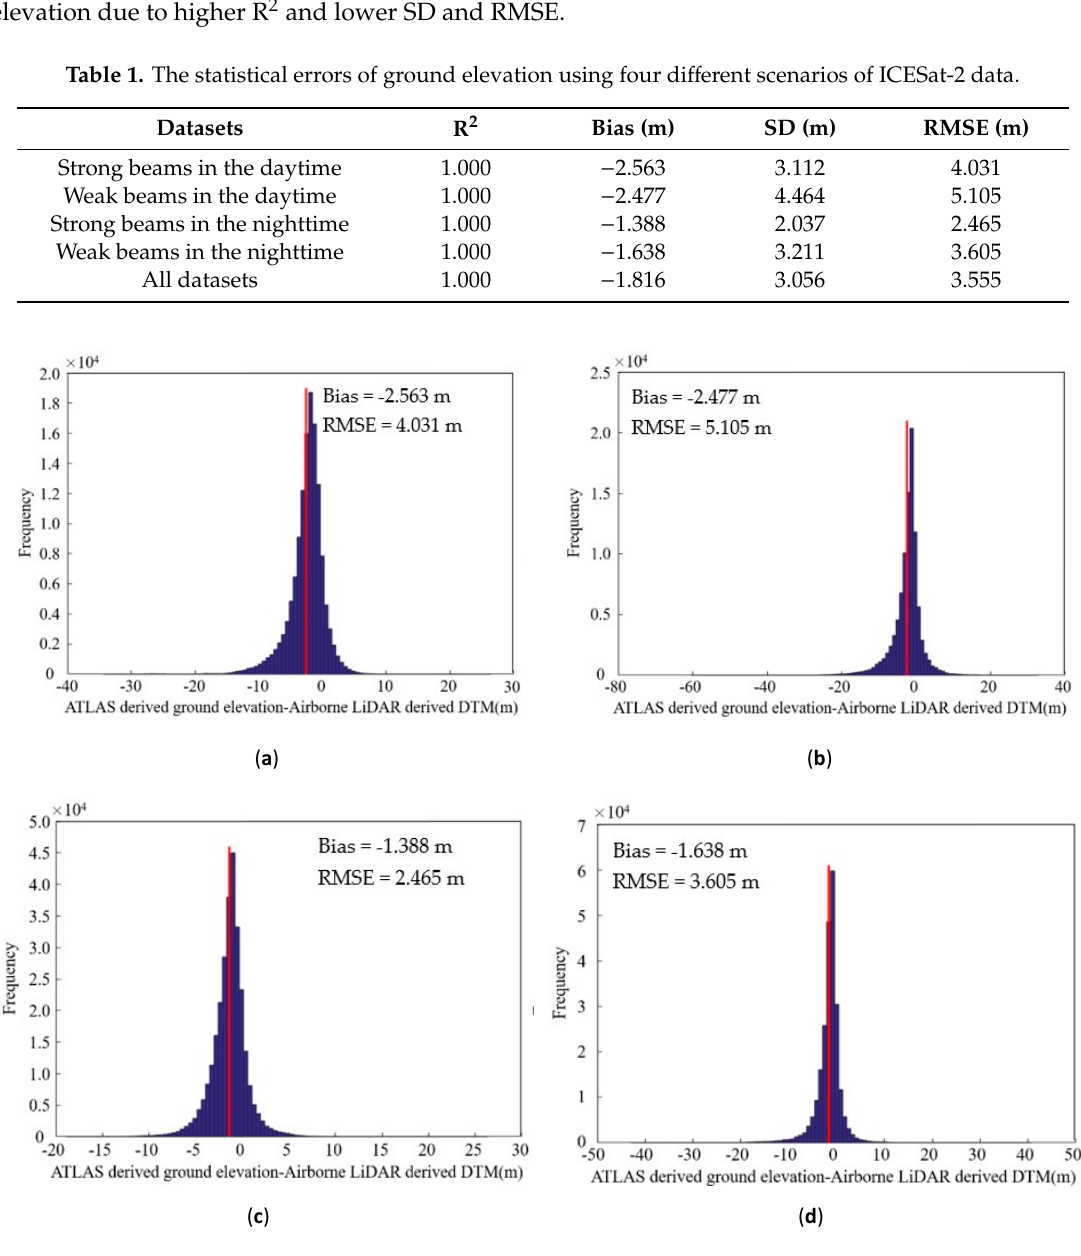
Figure 5. The frequency histogram of ground elevation errors using four different scenarios of ICESat-2 data ( a ) strong beams of ICESat-2 in the daytime, ( b ) weak beams of ICESat-2 in the daytime, ( c ) strong beams of ICESat-2 in the nighttime, and ( d ) weak beams of ICESat-2 in the nighttime.